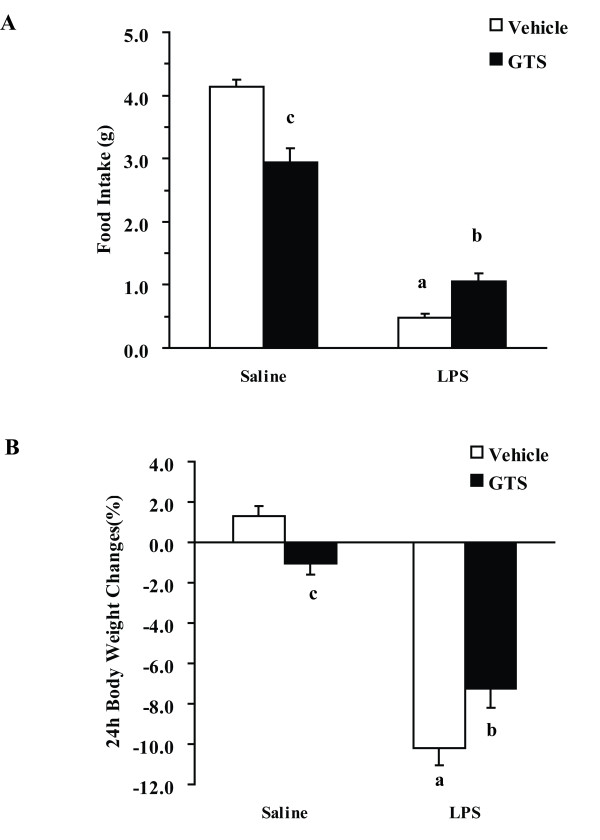
GTS improves LPS-associated anorexia and weight loss. Mice were administered orally with GTS at a dosage of 200 mg.kg-1 which was dissolved in saline once daily for 7 days prior to and on the same day of LPS injection. Immediately following the final injection, mice also received either an i.p. injection of sterile endotoxin-free saline or LPS (0.8 mgkg-1). The 22-h change in food intake (Figure.1A) and body weight loss (Figure.1B) following LPS administration were measured. The data are expressed as mean ± SEM. For statistical significance, a: p < 0.01 compared with the vehicle/saline group, b: p < 0.05 compared with the vehicle/LPS group. c: p < 0.01 compared with the LPS/GTS group.